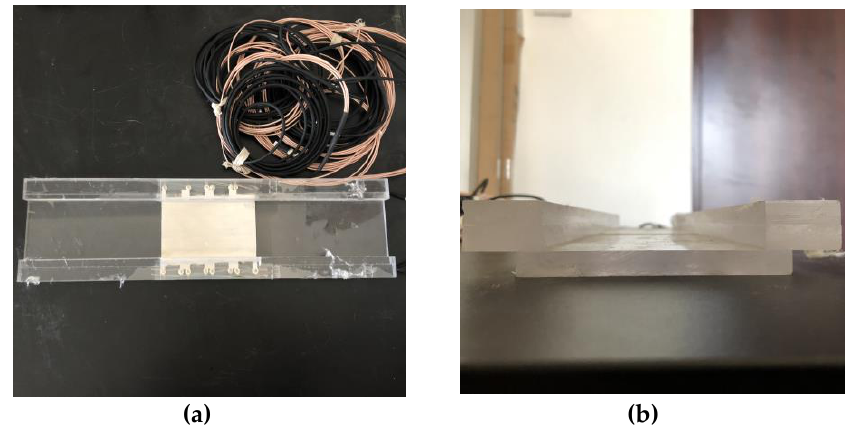
Figure 7. Photographs of PVDF sensor. ( a ) Top view of PVDF sensor, ( b ) Side view of PVDF sensor.